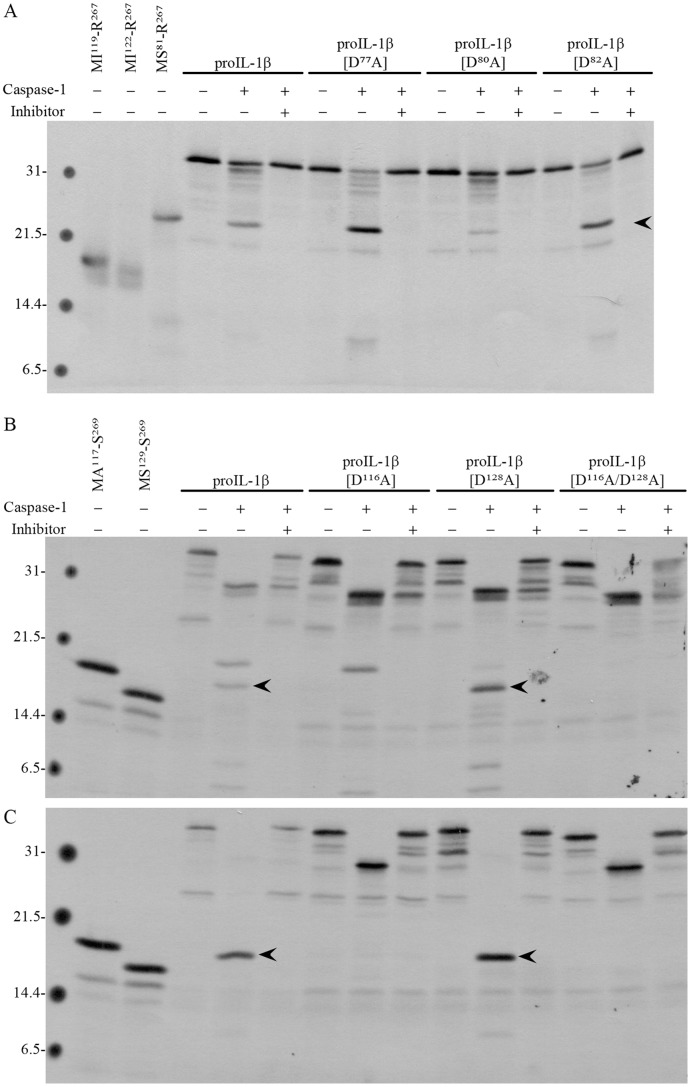
Processing of in vitro translated chicken and human proIL-1β by sea bass caspase-1. (A) Processing of in vitro translated chicken proIL-1β and mutants by sea bass caspase-1. The same volume of in vitro translated chicken proIL-1β, proIL1β[D77A], proIL1β[D80A] and proIL1β[D82A] were loaded on the gel. In vitro translated putative mature chicken IL-1β forms (MI119-R267, MI122-R267 and MS81-R267) were loaded as controls. (B) Processing of in vitro translated human proIL-1β and mutants by sea bass caspase-1. (C) Processing of in vitro translated human proIL-1β and mutants by human caspase-1. The same volume of in vitro tranlsated proIL-1β , proIL1β[D116A], proIL1β[D128A] and proIL1β[D116A/D128A] was loaded on the gel. In vitro translated mature human IL-1β (MA117-S269) and human IL-1β form (MS129-S269) starting at S129, homologue to sea bass S101, were loaded as controls. Mature forms are highlighted by arrow heads. Numbers on the left indicate the mass of the molecular weight markers in kDa.